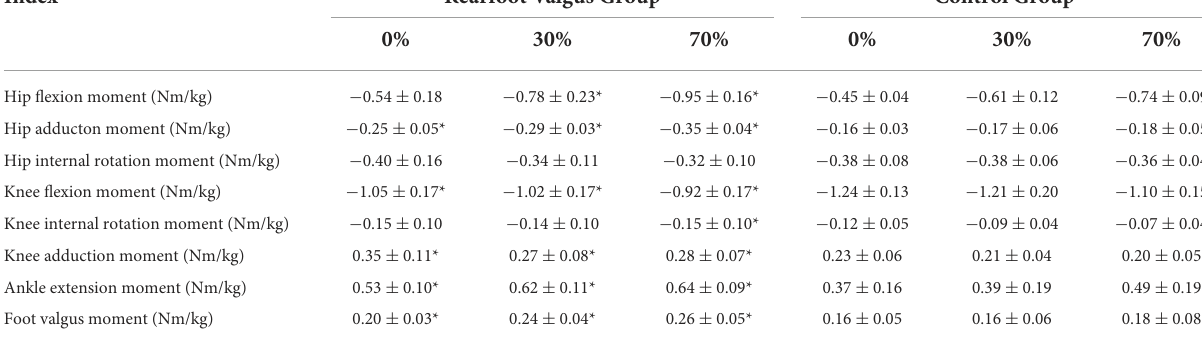
TABLE 3 Peak joint